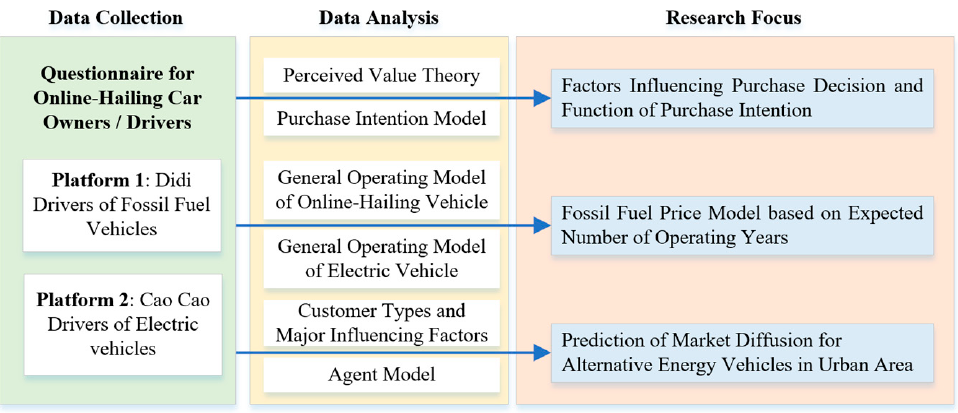
Figure 1. Structure of the paper.